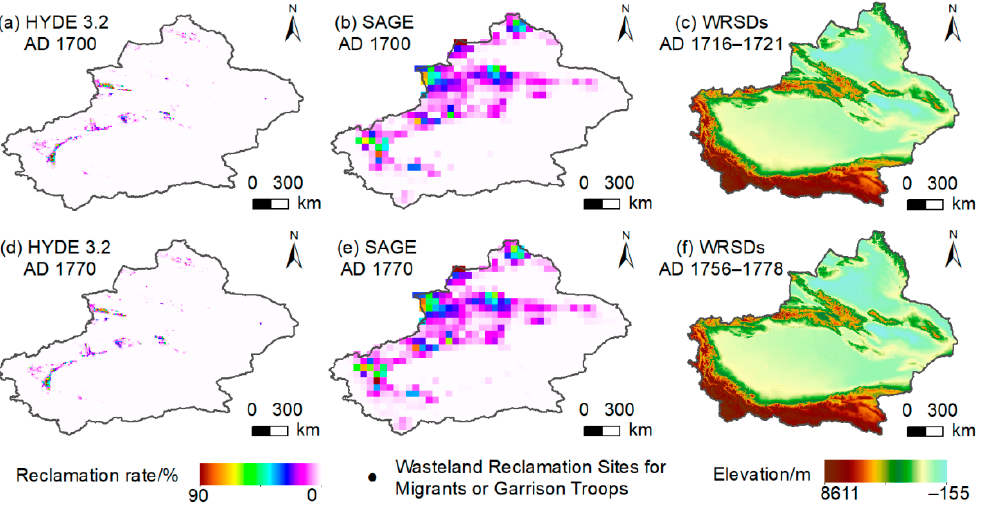
Figure 7. Cropland spatial patterns for AD 1700 and 1770 from HYDE 3.2 and SAGE and of wasteland reclamation sites in the early (AD 1716–1721) and middle Qing (AD 1756–1778) Dynasty in Xinjiang area.